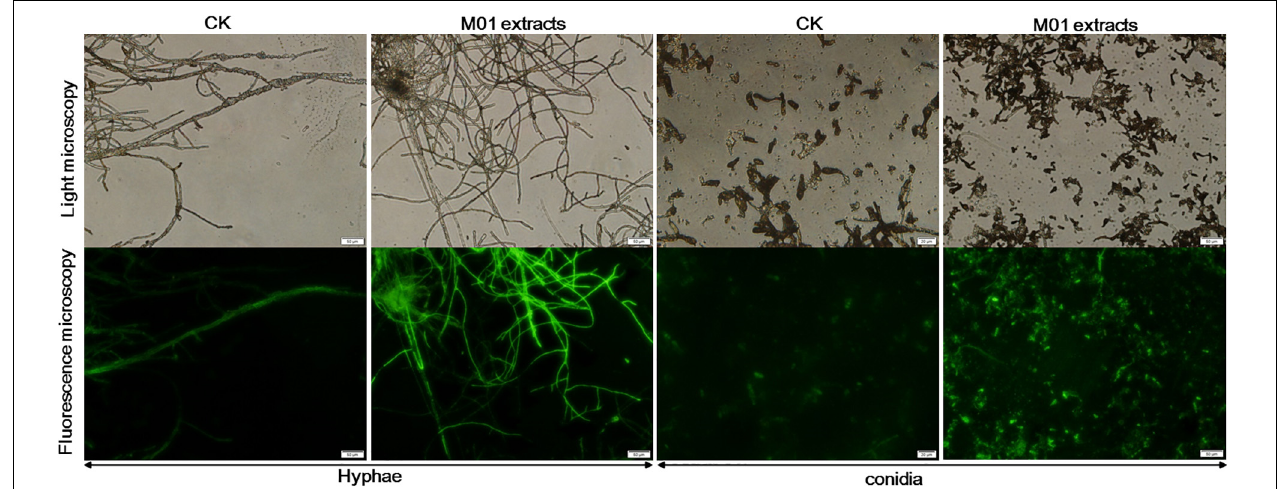
FIGURE 2 | Effect of S. lydicus M01 extracts on ROS production by A. alternata